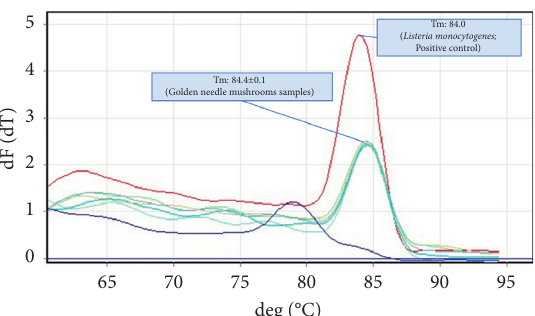
Figure 1: Comparison of Tm values in melting curve between Listeria monocytogenes in tryptic soy broth with 0.6% yeast extract media (positive control) and L. monocytogenes in golden needle mushroom samples. Table 1: Comparison of Tm values for the bacteria in melting curves for the bacteria. Bacteria